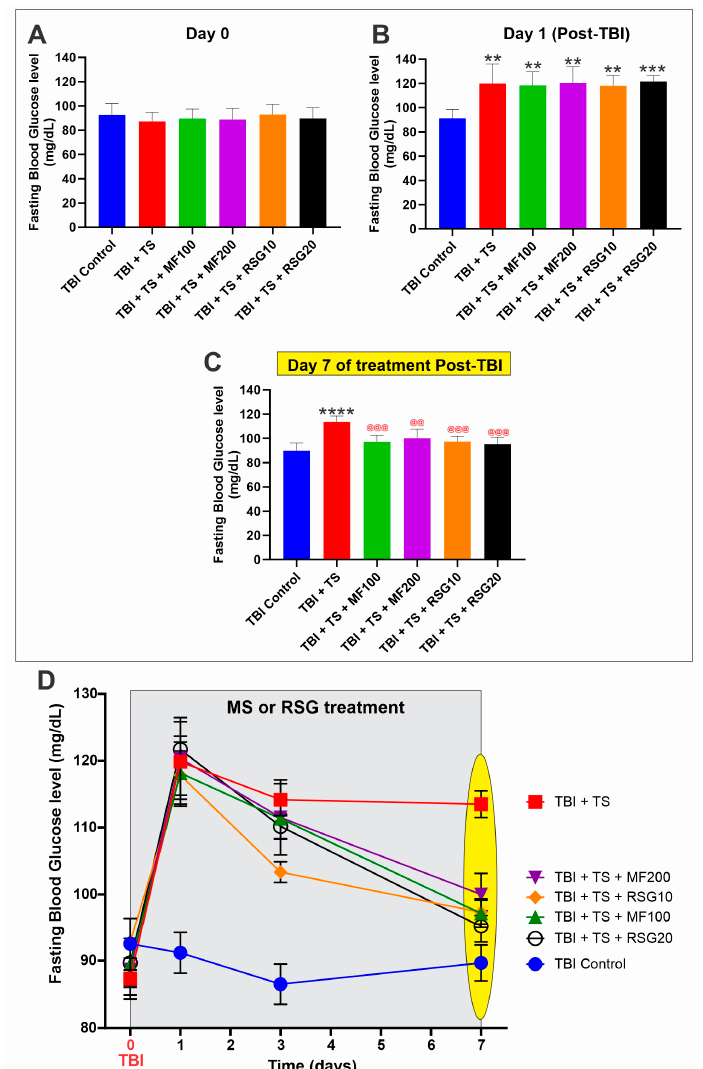
Figure 2. Effect of TS Exposure, MF, and RSG treatments on fasting blood glucose levels of TBI- induced mice. (A) Measurements of animals’ fasting blood glucose levels did not significantly differ between the tested groups at Day 0. However, significant differences between controls and test groups were evident from day 1 post-TBI ( B ). By day 7 post-TBI MF and RSG treatment showed to effectively controlled the rising glucose levels of TS-exposed mice ( C ). ( D ) Longitudinal representation of fasting blood glucose levels from time 0 to day 7 post-TBI. n = 6 biological replicates, ** p < 0.01, *** p < 0.001, **** p < 0.0001 versus control. @@ p < 0.01, @@@ p < 0.001, non-treated versus MF/RSG- treated